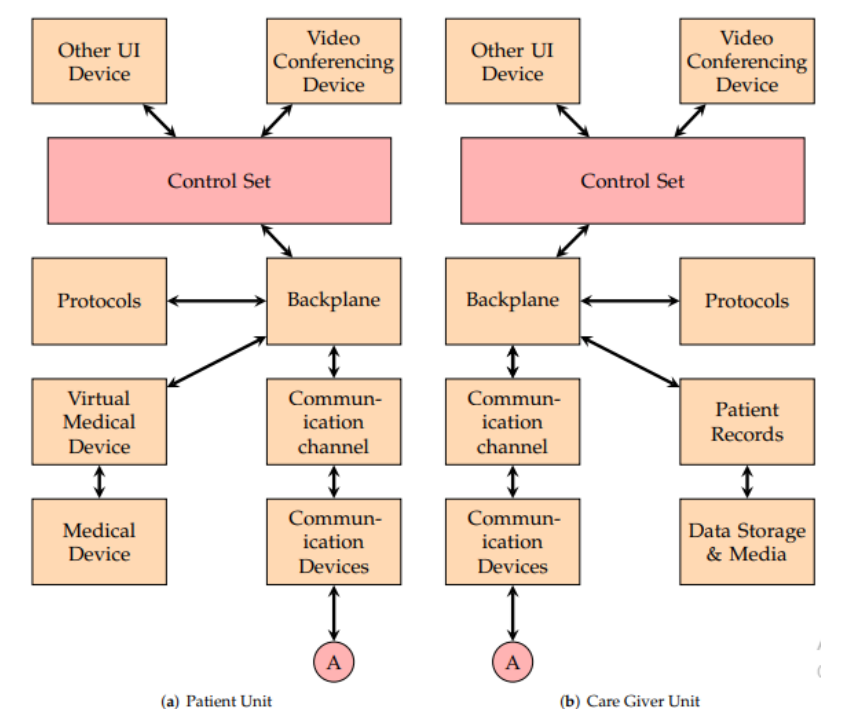
Figure 2. Block Diagram of Telemedicine